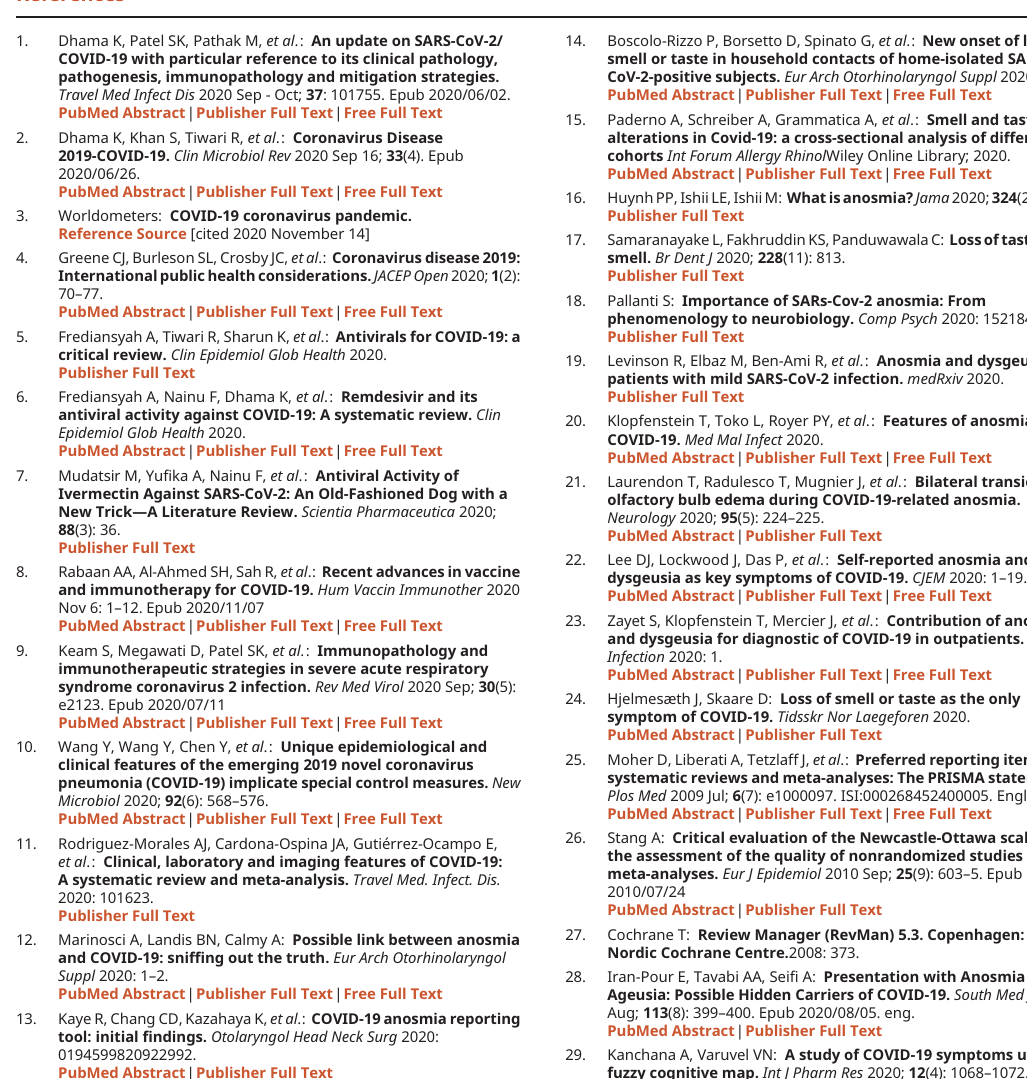
Figshare: PRISMA checklist for ‘ Anosmia and dysgeusia in SARS-CoV-2 infection: Incidence, effects on COVID-19 severity and mortality, and the possible pathobiology mechanisms - A systematic review and meta-analysis ’ , https://doi. org/10.6084/m9.figshare.13323080.v1 294 . Data are available under the terms of the Creative Commons Attribution 4.0 International license (CC-BY